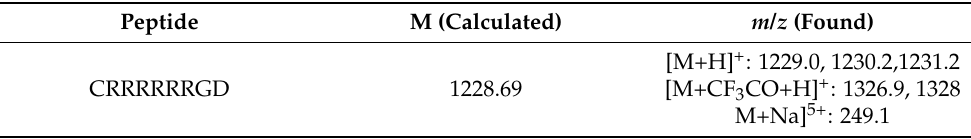
Table 1. ESI-MS analysis of tumor-targeting peptide.